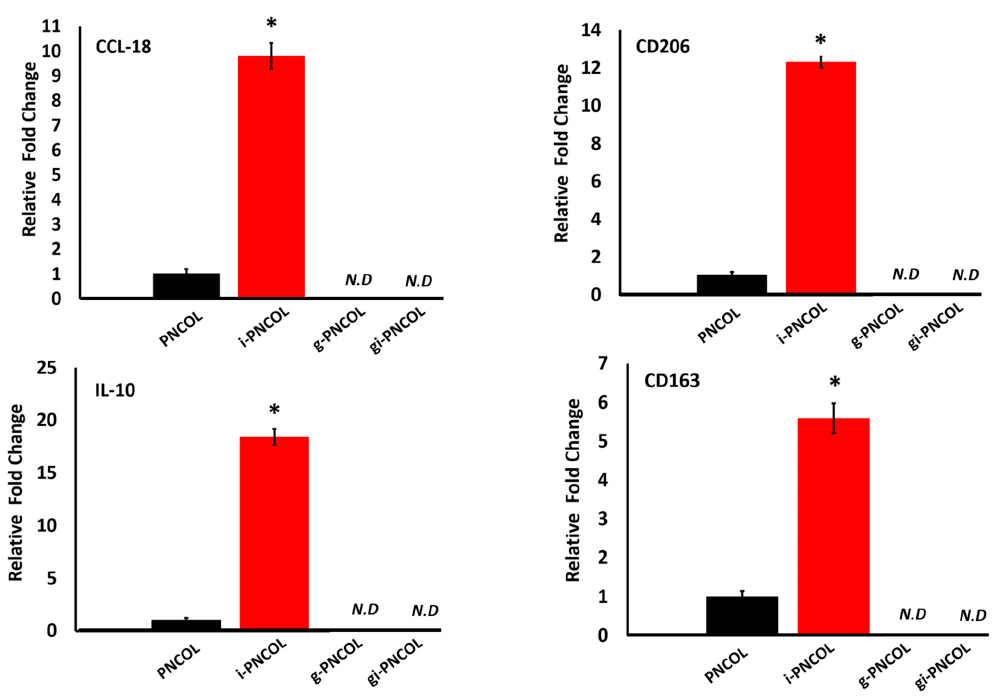
Figure 9. The relative expression of anti-inflammatory (M2) genes. Star sign (*) indicates a significant difference between sample groups. Student’s paired t ‐ test was used, p < 0.05. N.D indicates Not Detected gene expressions.